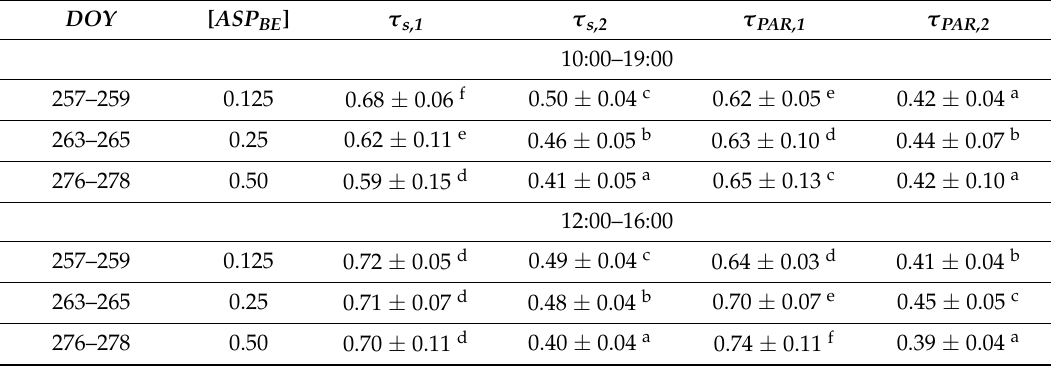
Table 3. Mean values of transmissivity of the greenhouse cover in sector 1 (without ASP BE ) and sector 2 (with ASP BE ) for the autumn experiments. DOY , day of year; [ ASP BE ], concentration in kg L − 1 ; τ s , transmissivity to solar radiation; τ PAR , transmissivity to PAR; R s , inside solar radiation; subscript: 1 , sector 1 (without ASP BE ); 2 , sector 2 (with ASP BE ). DOY [ ASP BE ] τ s,1 τ s,2 τ PAR,1 τ